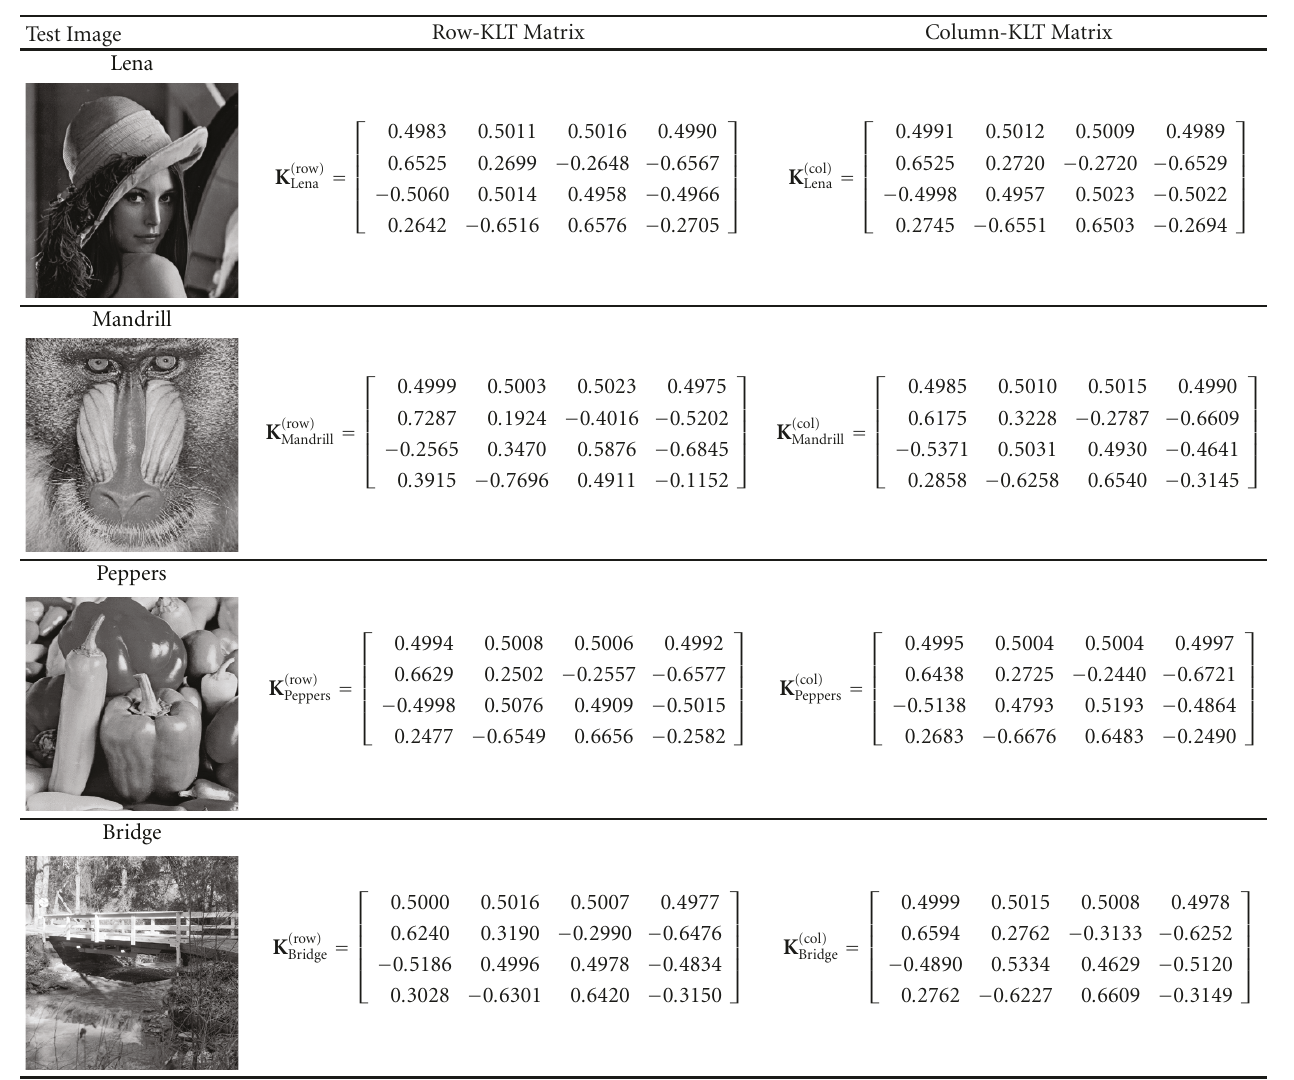
Table 1: Test images and their row- and column-KLT